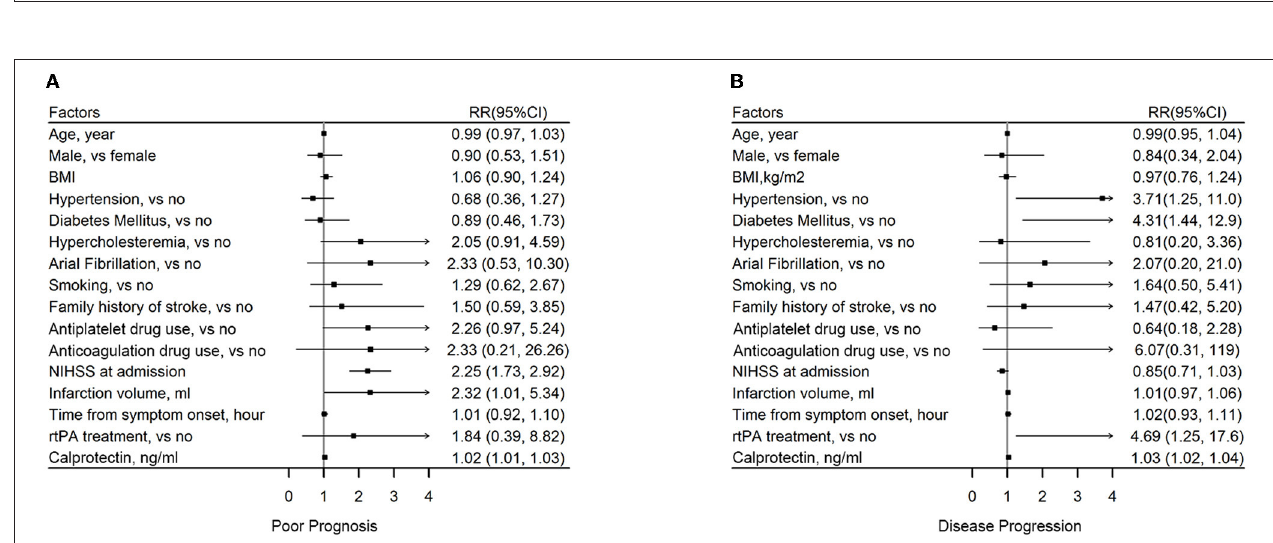
FIGURE 4 | Association between plasma calprotectin and short-term functional outcomes of AIS. (A) Risk factors of poor outcome 2 weeks after AIS onset as reflected by mRS ≥ 3. (B) Risk factors of disease progression during a 2-week follow-up as reflected by an increase in NIHSS score.